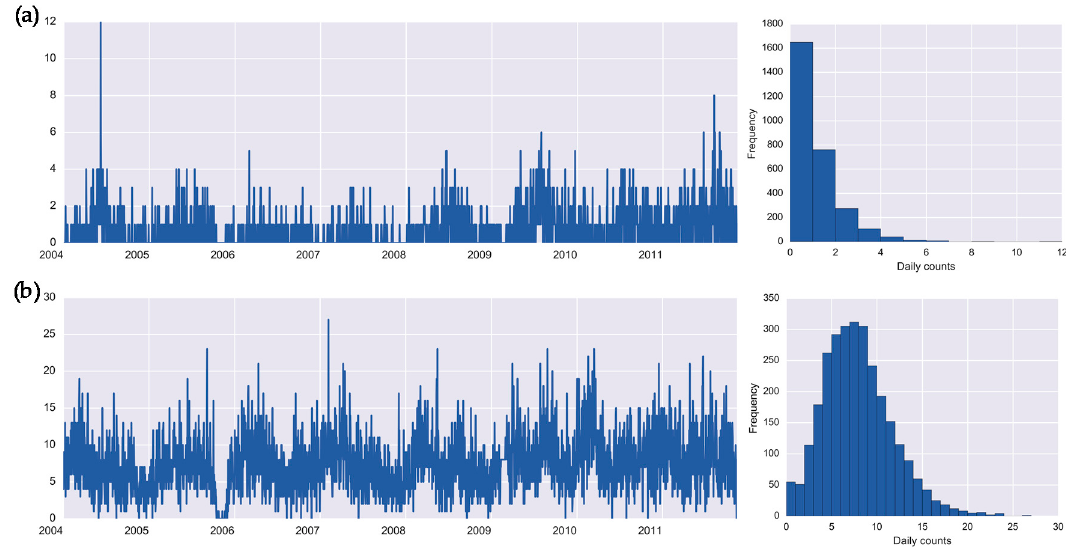
Figure 1. Daily time series and histograms for health outcomes: ( a ) salmonellosis, A02.8, and ( b ) enteritis, A04.9 in Barnaul, Russia in